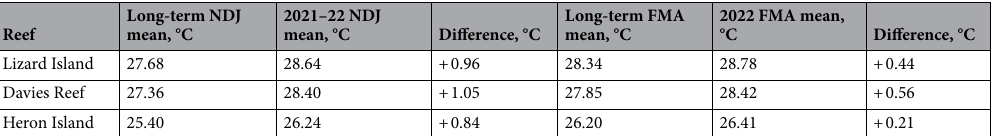
2021–22 NDJ mean, °C Difference, °C